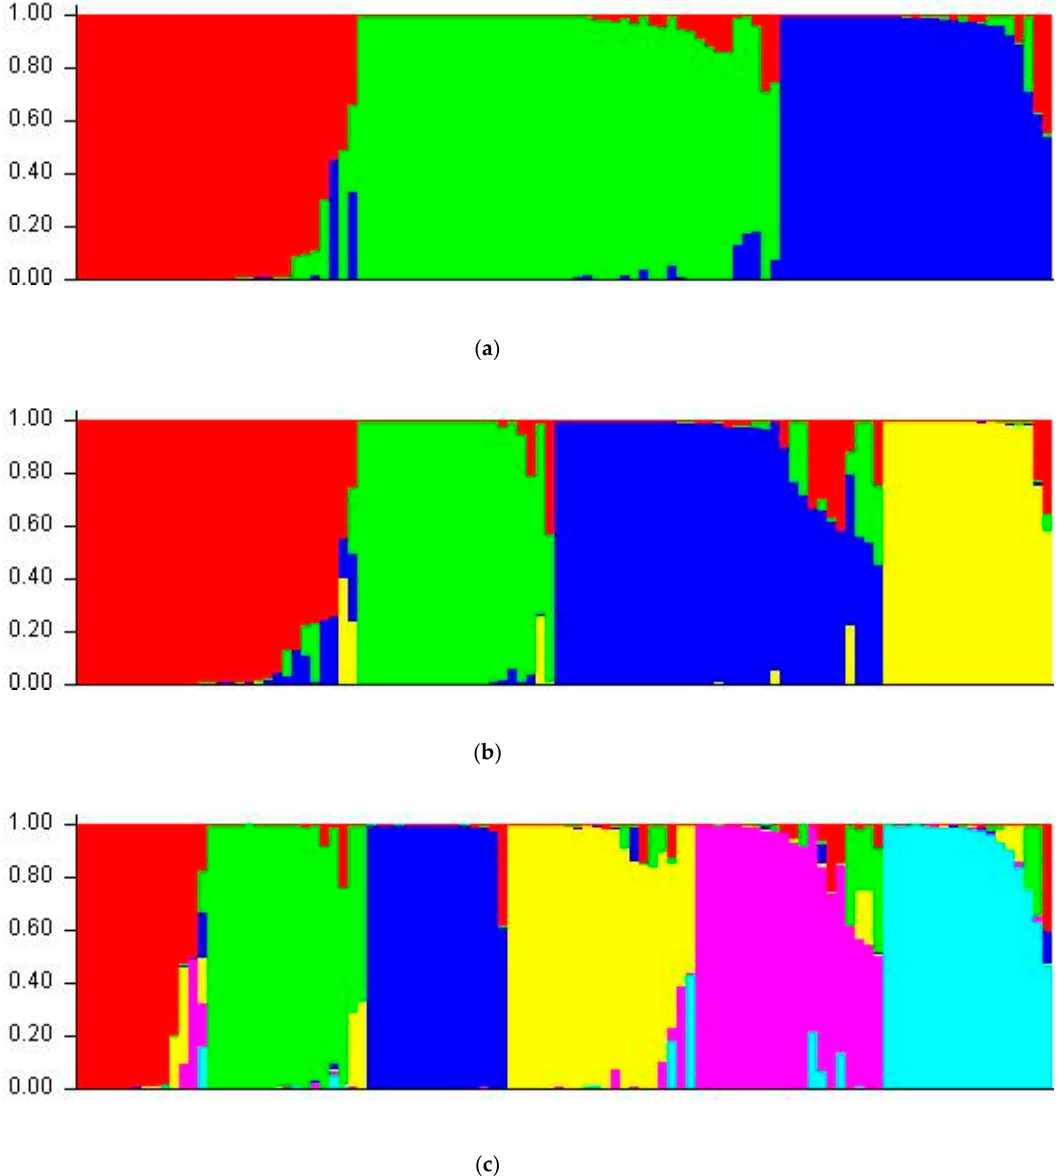
Figure 6. Population structure among individuals with ( a ) Δ K = 3, ( b ) Δ K = 4, and ( c ) Δ K = 6. Table 3. Proportion of membership of each predefined population from structure analysis ( Δ K = 3).